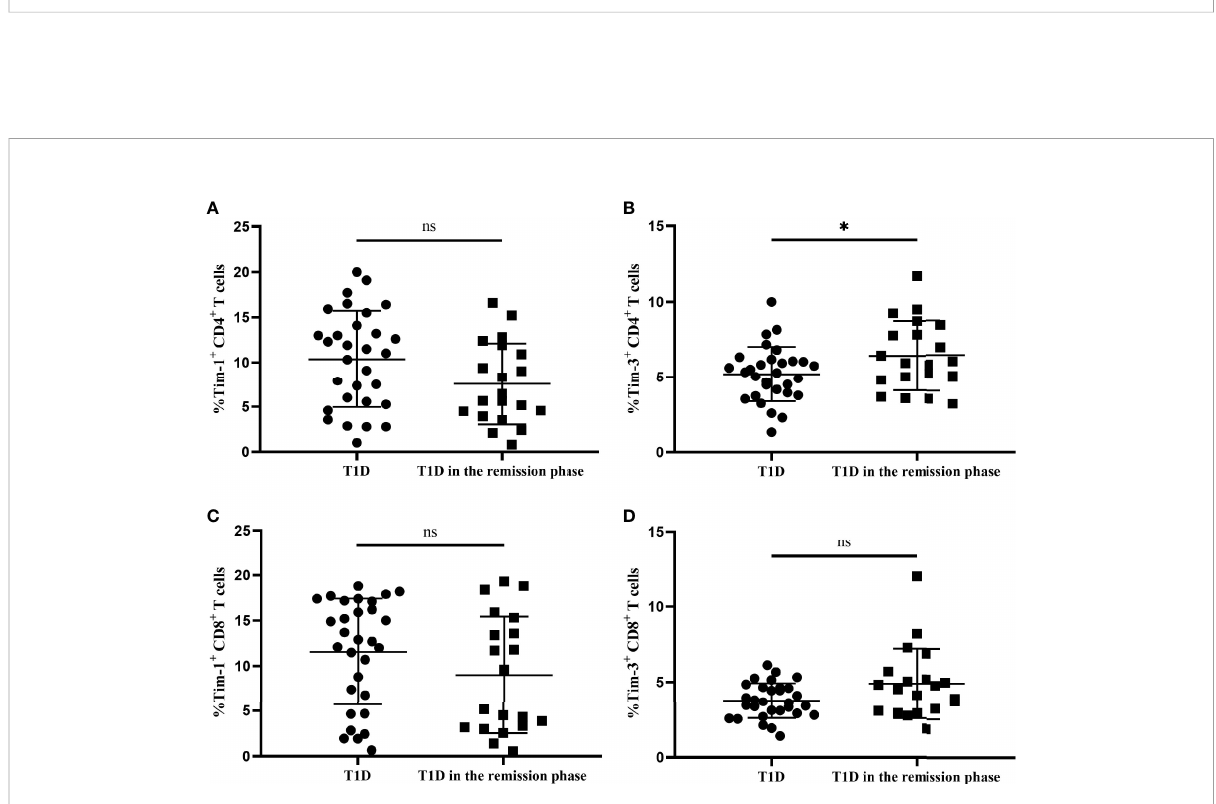
FIGURE 5 The Tim-1 and Tim-3 expression in T-cell subsets from T1D and T1D in the remission phase. (A) Alterations in the expression of Tim-1 + CD4 + T cells from T1D in the remission phase compared with T1D. (B) Alterations in the expression of Tim-3 + CD4 + T cells from T1D in the remission phase compared with T1D. (C) Alterations in the expression of Tim-1 + CD8 + T cells from T1D in the remission phase compared with T1D. (D) Alterations in the expression of Tim-3 + CD8 + T cells from T1D in the remission phase compared with T1D. ns, no statistical difference; * P